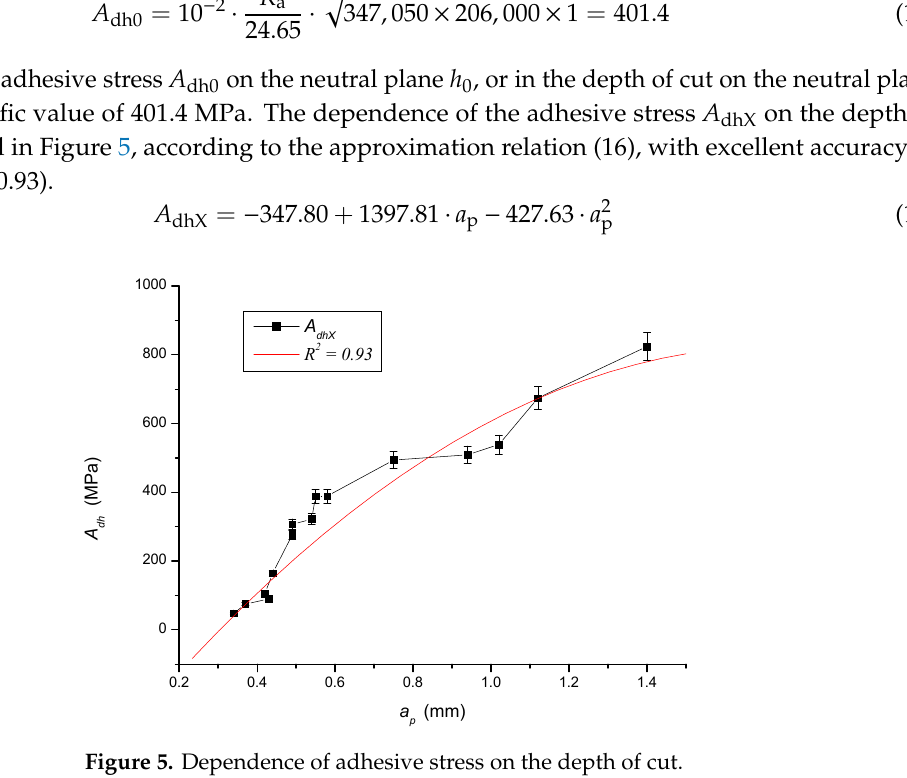
Figure 5. Dependence of adhesive stress on the depth of cut.